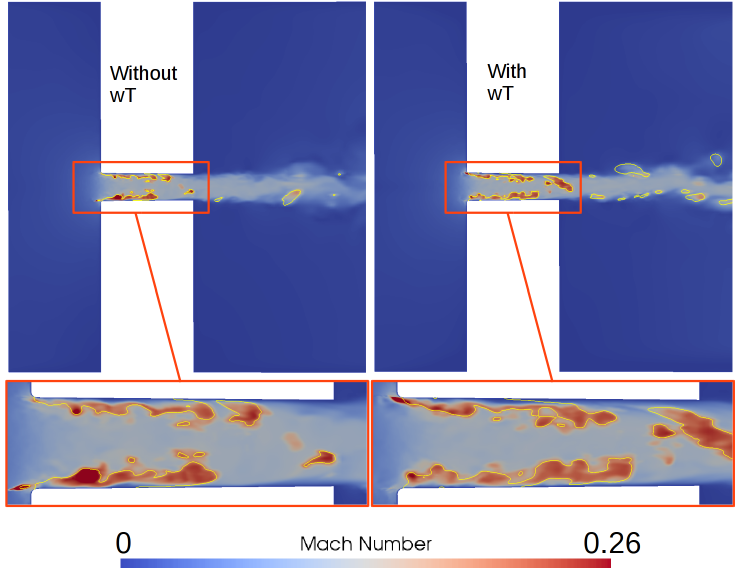
Figure 15. Colour distribution of the Mach number across the nozzle region (12 mm) at p dif f = 8.5 MPa calculated from the mixture compressibility. An enlargement of the nozzle area is included. The yellow line indicates the 0.5 isocontour of the vapour volume fraction.